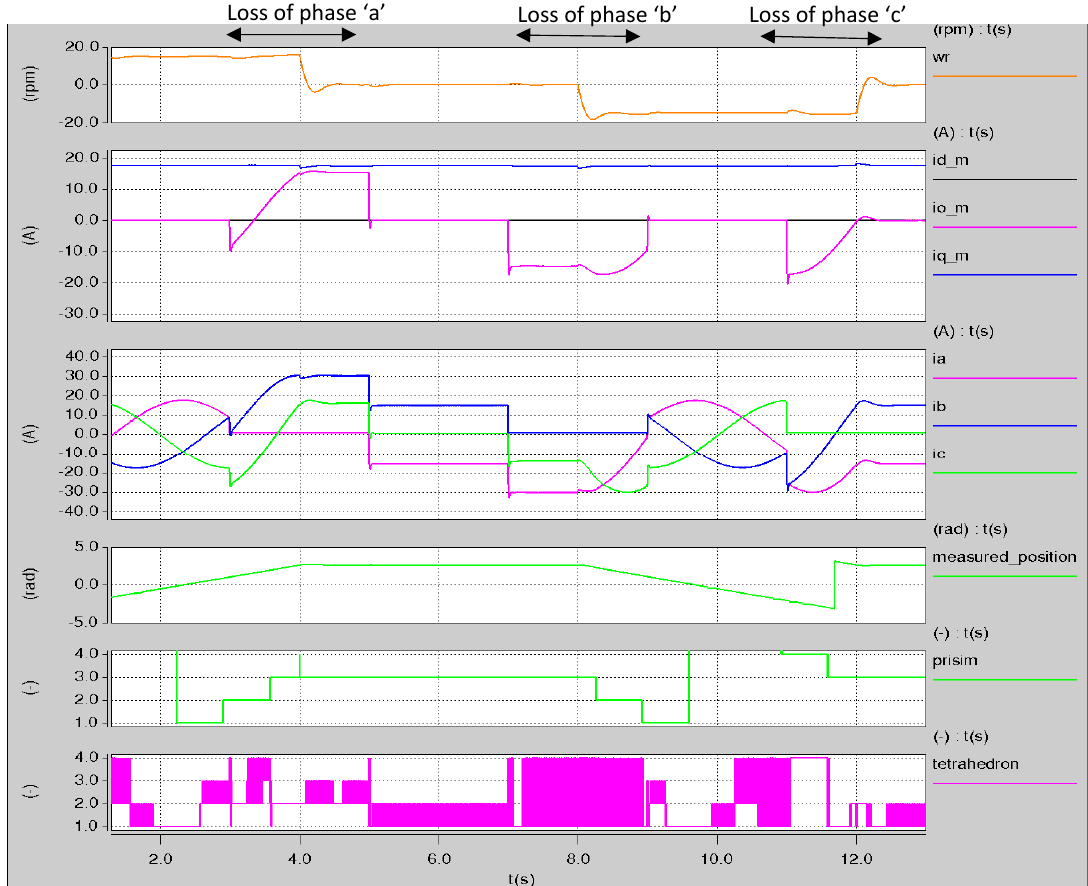
Figure 11. Closed-loop field-oriented encoderless speed control topology using 3D-SVPWM under a loss of one phase.